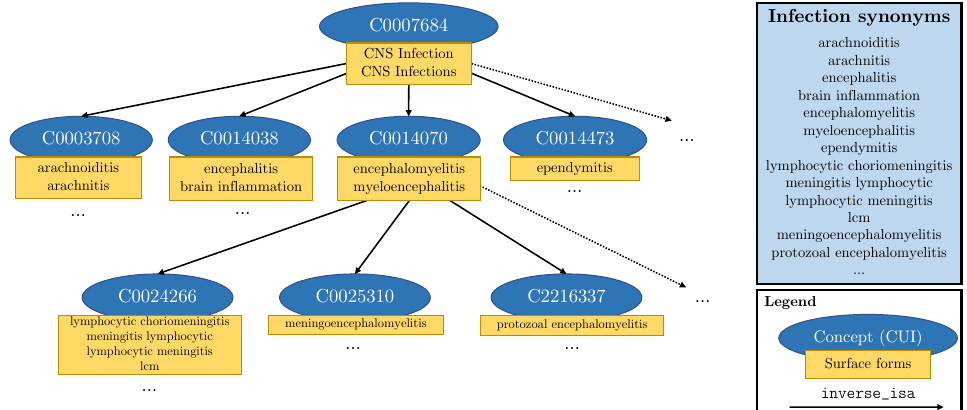
Figure 6. Schematic representation of a part of the subgraph of the UMLS meta-thesaurus used to extract synonyms for infection . Blue ovals represent individual concepts (CUIs), while the attached yellow rectangles contain the different surface forms of that concept. Each arrow represents an inverse_isa relationship.